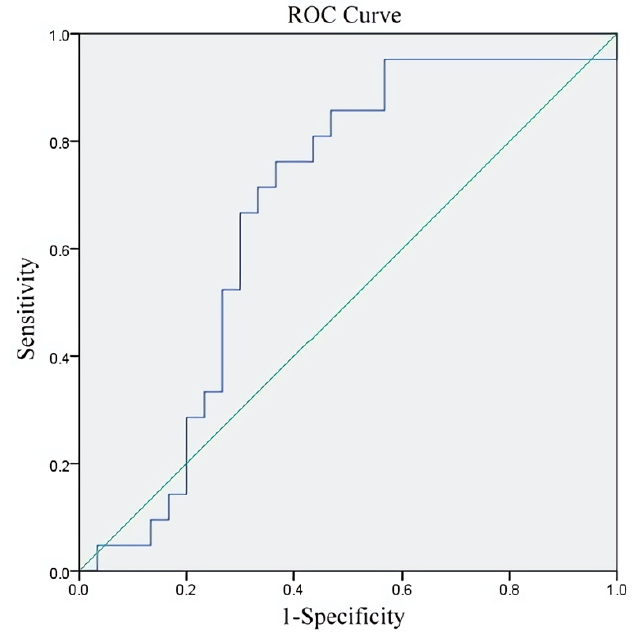
Figure 3. Predictive value of granulosa cell TL for aneuploidy rate in young-age